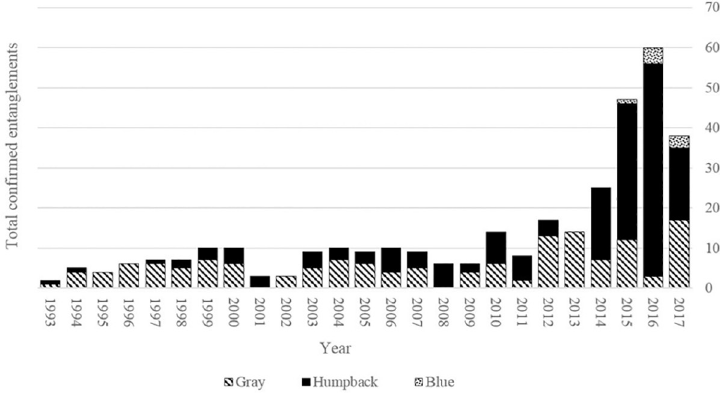
Fig 1. Total number of confirmed humpback (solid black), blue (dotted pattern) and gray whale (diagonal stripes) entanglements in fishing gear from 1993 to 2017 off the coast of California [32, Lauren Saez, pers. comm.].